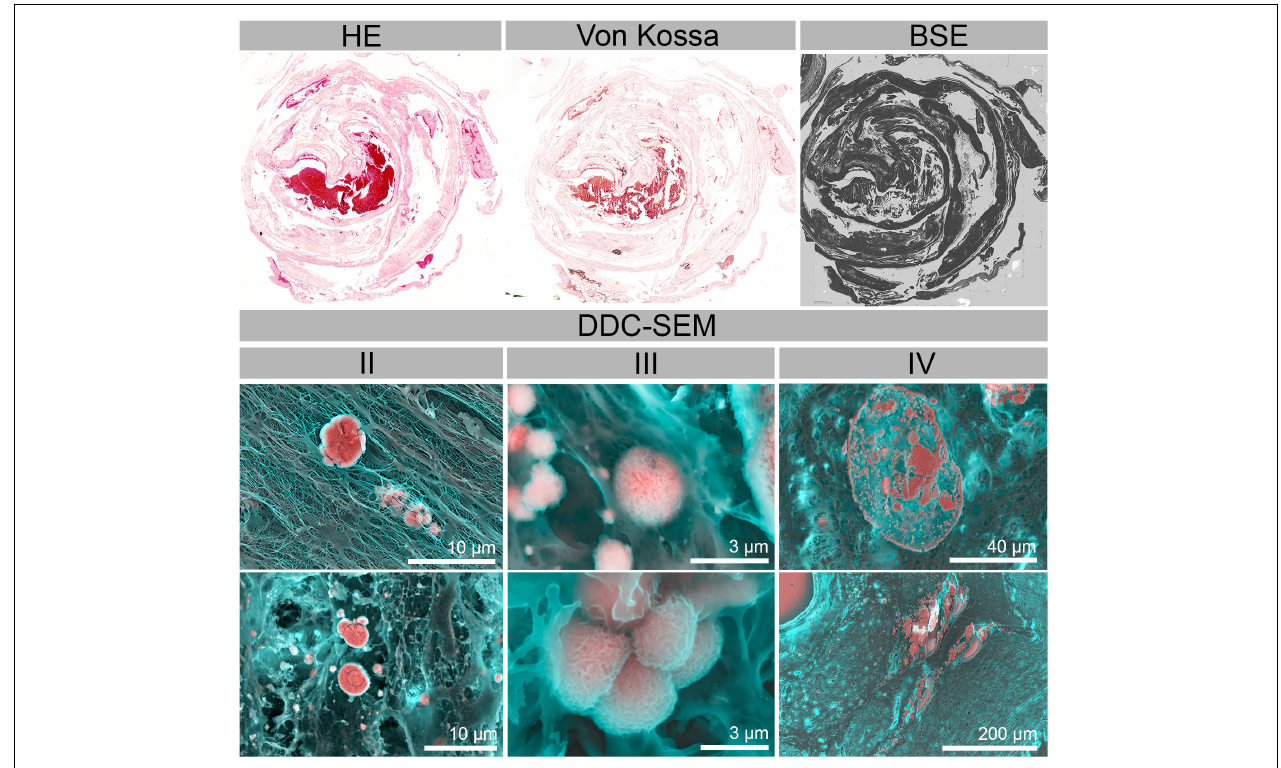
FIGURE 6 | Hematoxylin eosin (HE) and von Kossa-stained histological section as well as a WS-SEM—BSE micrograph of a calcified decidua with amnion. Types of calcified particles found in selected regions [type II (large spherical calcifications), III (small spherical rough particles) and IV (large block calcifications)] are displayed in DDC-SEM